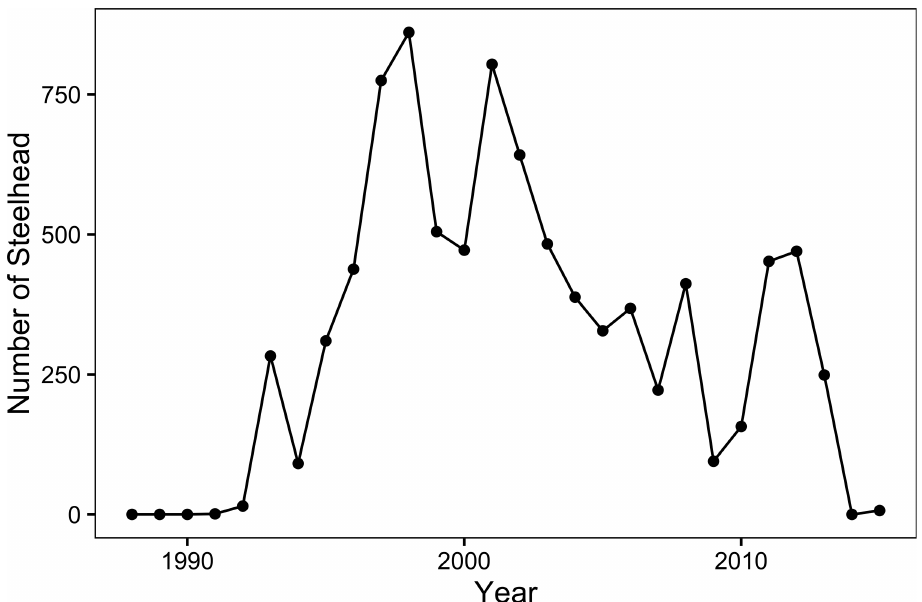
Fig 1. Annual counts of adult steelhead migrating past San Clemente Dam. Droughtscombinedwith water pumpingcompletely preventedmigratory access between river and ocean during1988–1991and 2014. A captive-broodstock effort by the Carmel River SteelheadAssociationcontributed to the rapid recovery of the run after the 1987–1992 drought. Locationof San ClementeDam is shown in Fig 2.